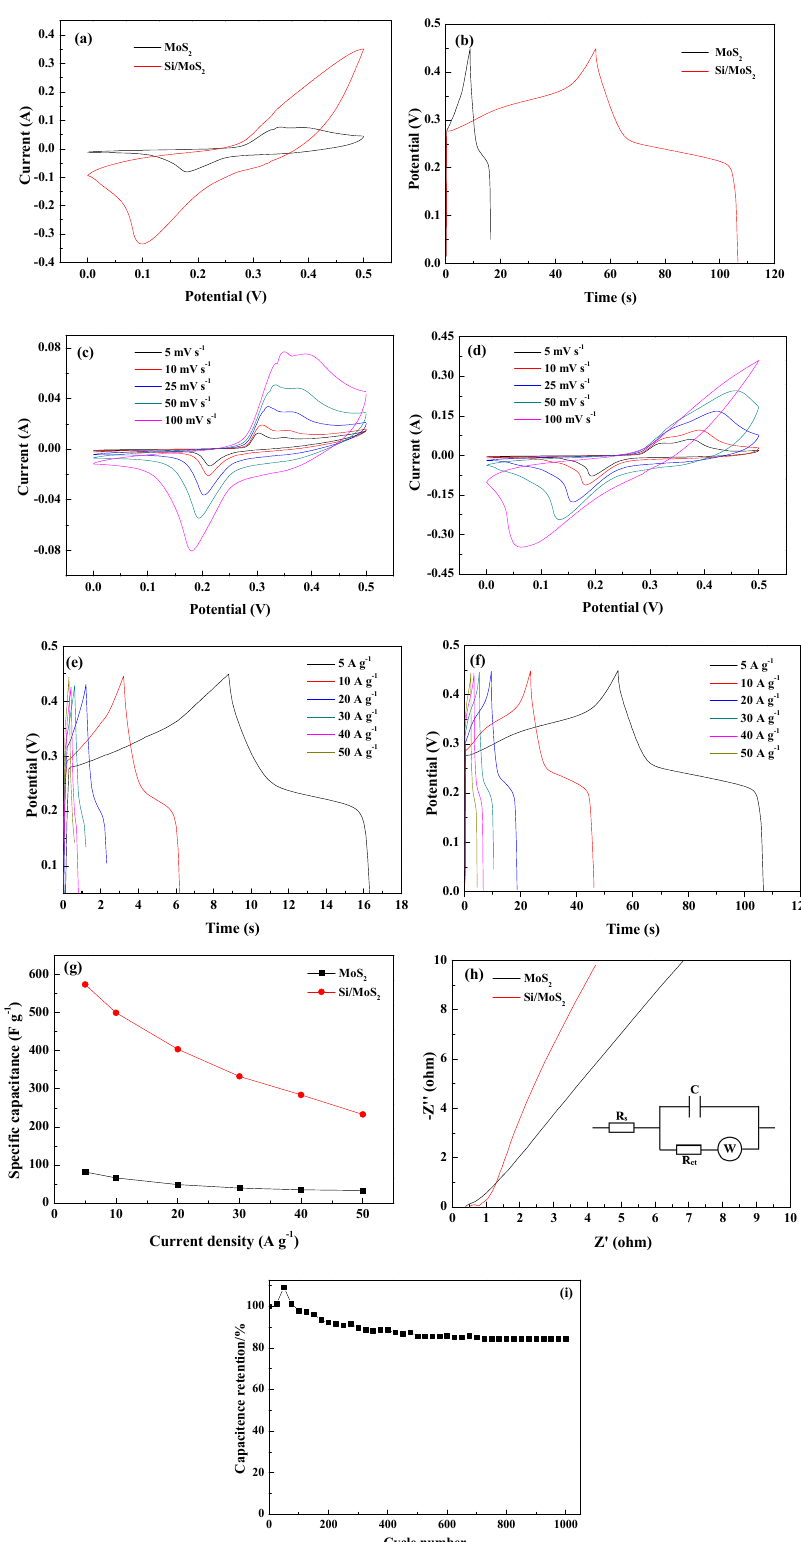
Figure 6. ( a,b ) Comparison of CV and GCD curves of two electrodes; ( c,e ) CV and GCD curves of MoS 2 and ( d,f ) Si/MoS 2 composite; ( g ) rate capacitance calculated by GCD curves; ( h ) EIS curves of two electrodes (the inset shows the equivalent circuit model used for fitting the EIS plot ); ( i ) cyclic stability test at 1 A·g − 1 for Si/MoS 2 composite electrode.